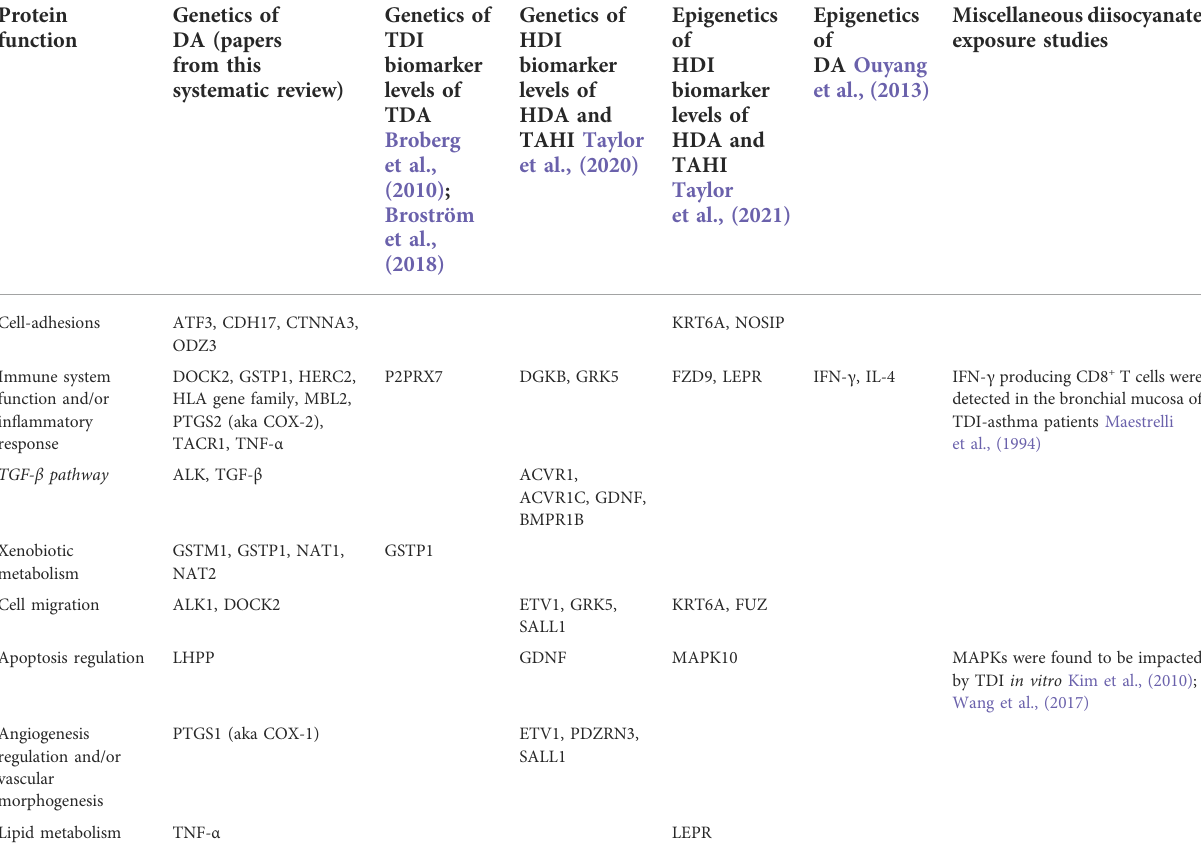
TABLE 3 Overlap between DA prevalence predicted protein network functions from this literature review and other diisocyanate research including exposure biomarker research, epigenetics of DA research, and in vitro studies. Genes with associations within the studies in the columns are grouped by protein function and show overlapping themes for the types of protein functions that are associated with diisocyanate studies. Protein